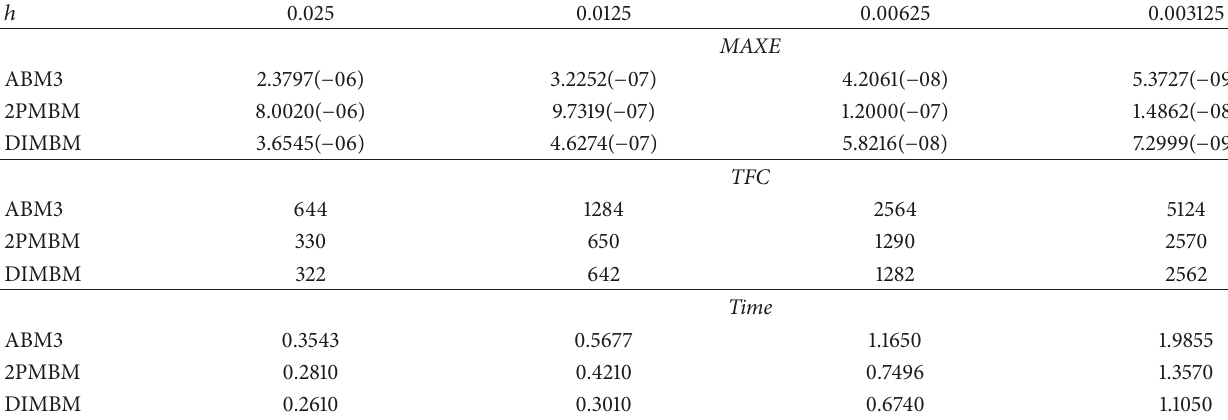
Table 3: Numerical results for Example